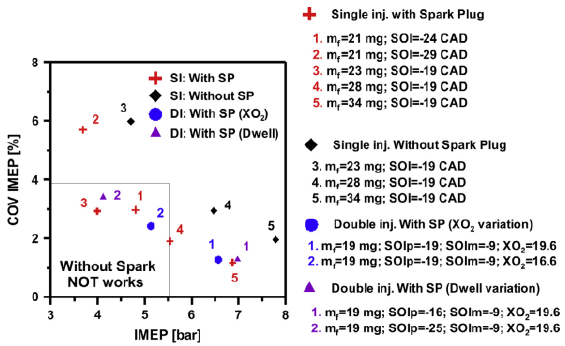
Fig. 11 Effect of spark assistance on CoV under different injection strategies [81].